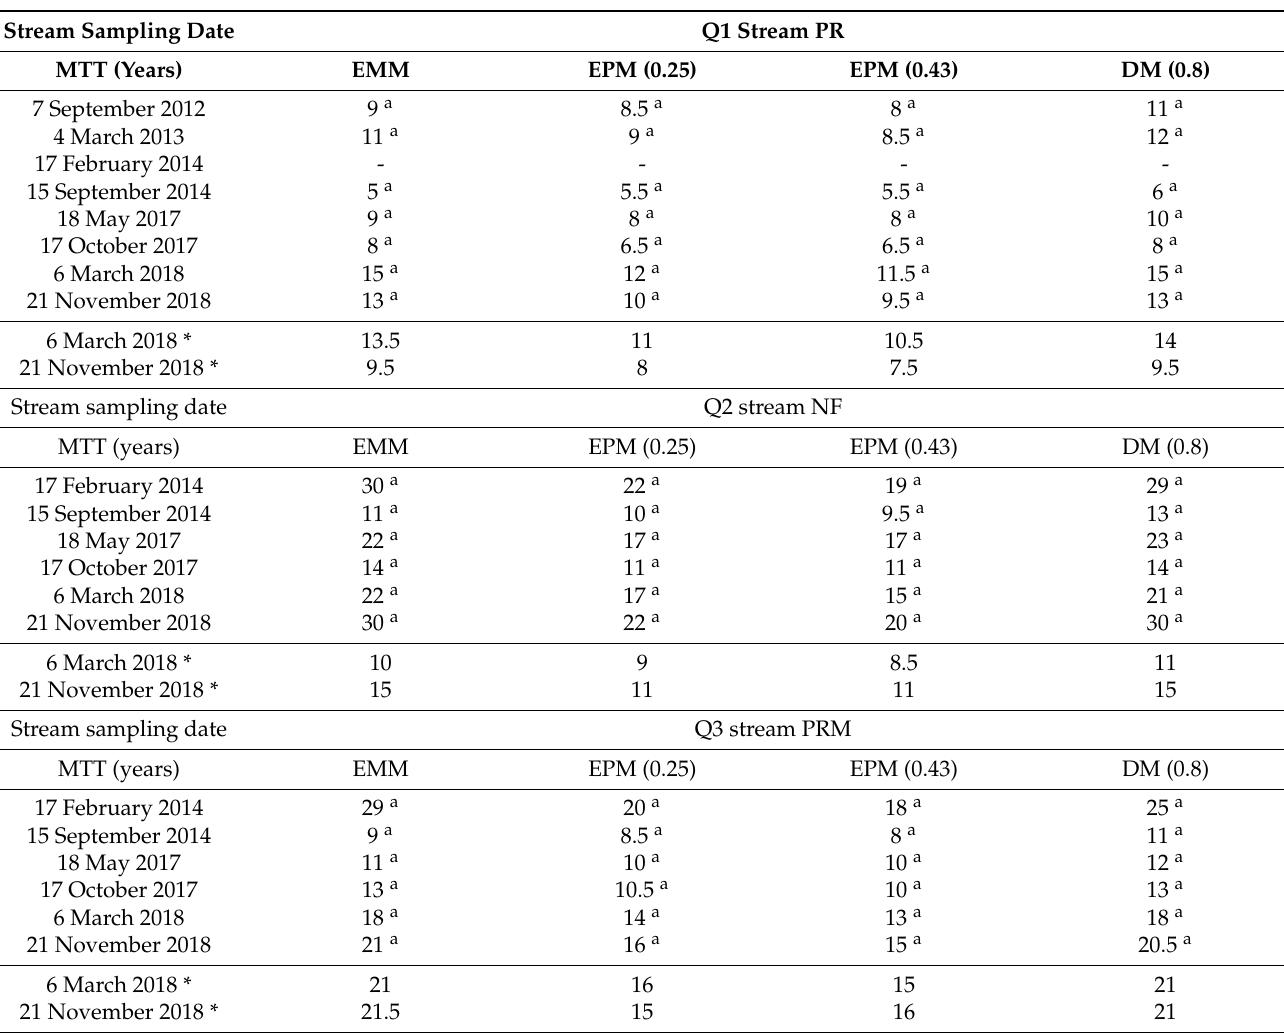
Table 8. Mean transit time (years) for all catchments by each of the